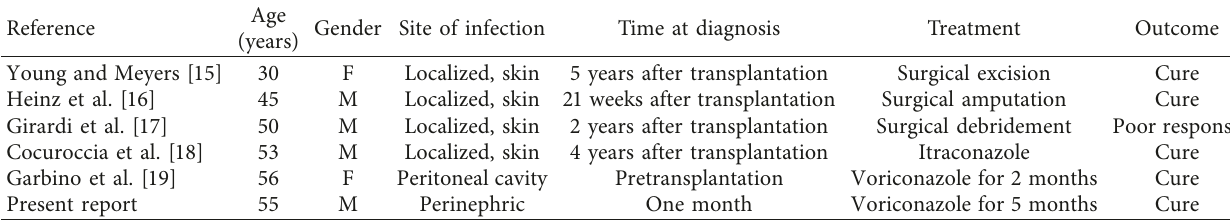
Table 1: Fusarium infection in kidney transplant